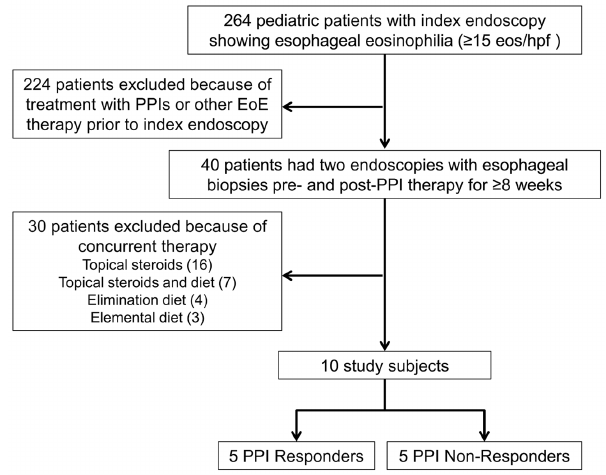
Figure 1. Flow diagram of study subject selection.